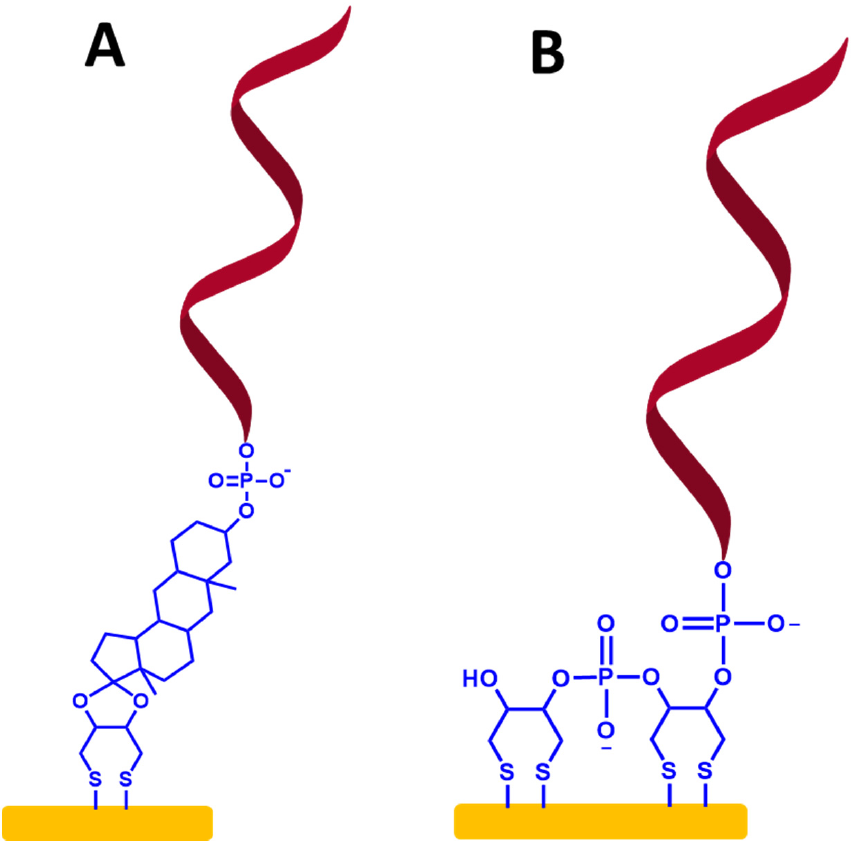
Figure 9. ( A , B ) Self-assembled monolayer ssDNA probes on the gold electrode surface-based dithiol groups. The relative sizes of gold electrodes, dithiol groups, and ssDNA chains are not to scale.